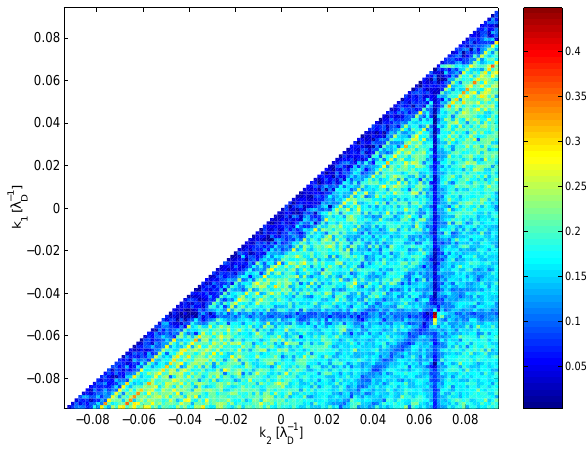
Fig. 5. The cross-bicoherence b EEρ (k 1 ,k 2 ) between ρ end E . The Nyquist wave number is 0 . 4 λ − 1 , but only the part of the principal D domain corresponding to significant power density is shown. Not all of the usual symmetries of bicoherence apply, due to the asym- metry of the power density | E k | 2 . The peak value of 0.45 at (0.066, -0.052) identifies a strong three-wave phase coupling of the type l 0 . 066 ↔ l − 0 . 052 + s 0 . 118